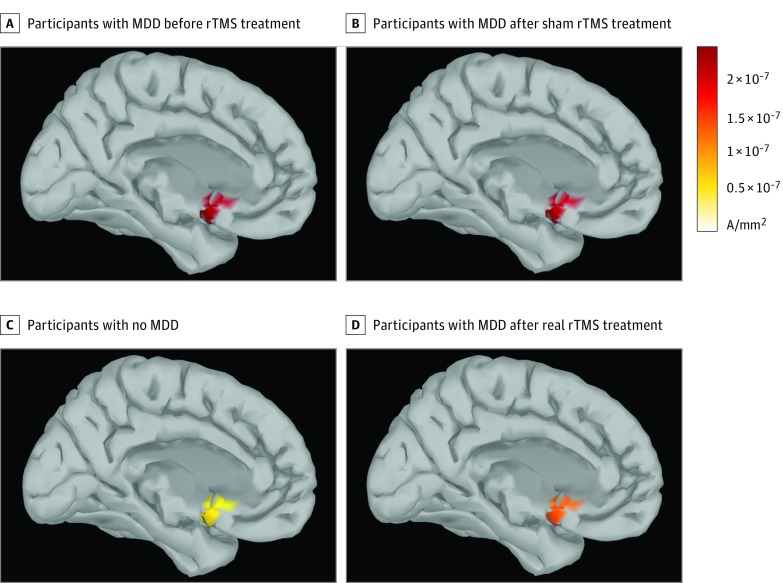
Current Density at the Subgenual Cingulate Cortex Region of Interest After Repetitive Transcranial Magnetic Stimulation (rTMS) PulseMDD indicates major depressive disorder.